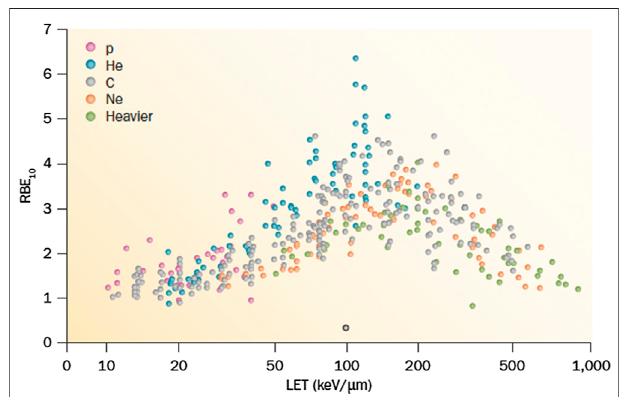
FIGURE7| Acollection ofdifferentRBEvaluesfordifferentcelllinesasa function ofLET. Datafrom the PIDE database, available online at www.gsi.de/ bio-pide.